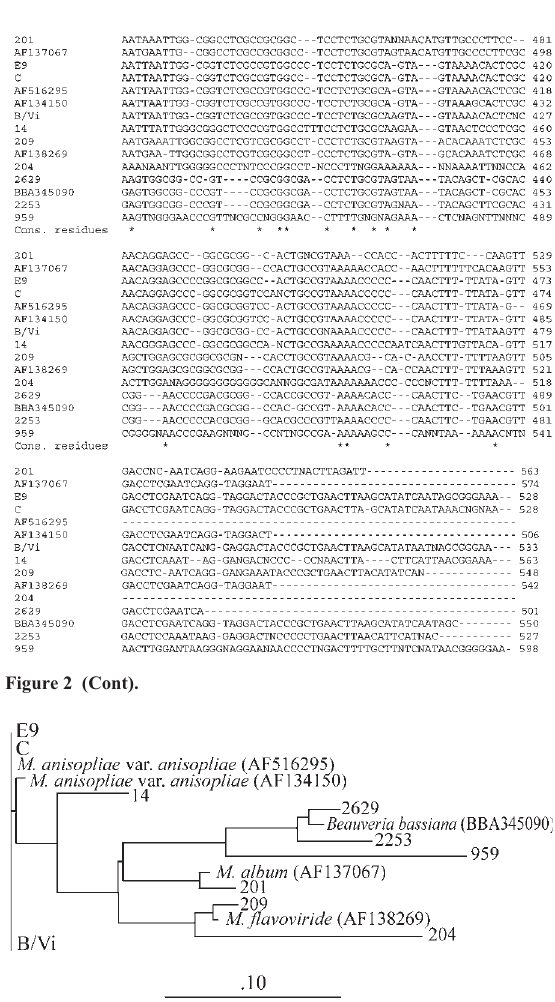
Figure 5 - PCR-RFLP profiles of Metarhizium anisopliae var. anisopliae strain E 9 using the ITSMet/ITS4 primer set with the restriction enzymes Afa I, Alu I, Dde I, Hae III, Sau 3A I and Taq I. 1 = DNA from a pure cul- ture of strain E 9 ; 2 = DNA from larvae infected with strain E 9 . M = 100 bp DNA